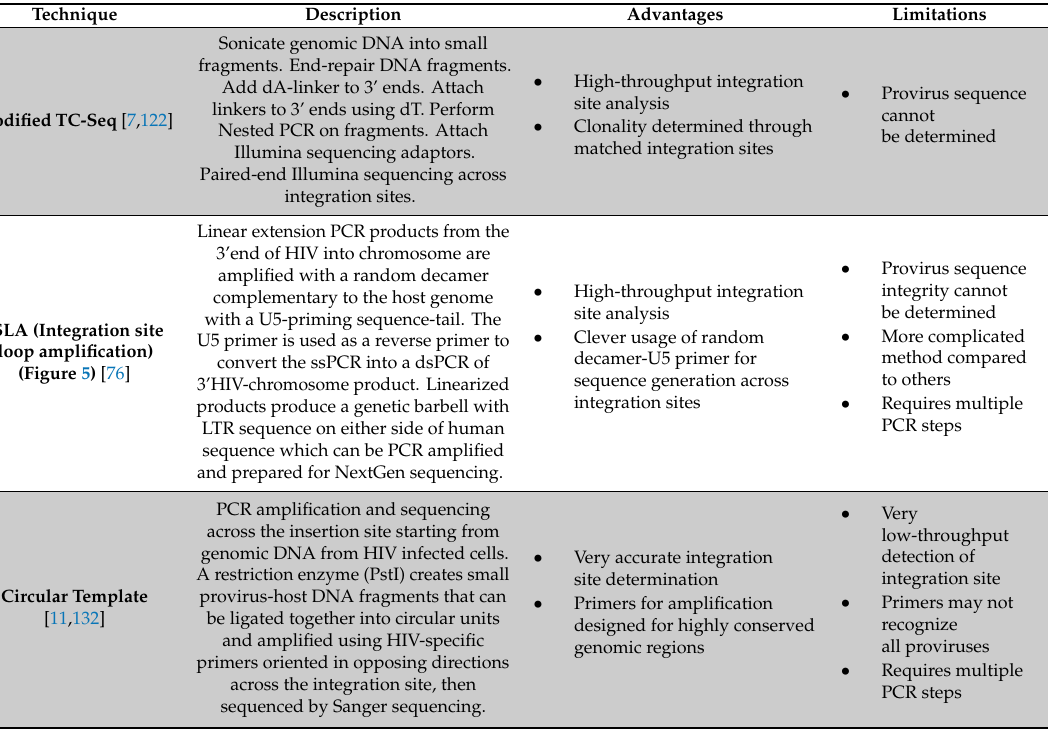
Table 1. Integration Site